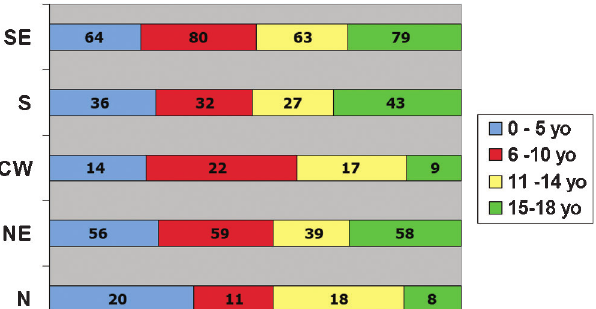
Figure 4 - Comparative distribution of all cases of pediatric lymphomas by age groups in each geographic region. N: North; NE: Northeast; CW: Central-West; S: South; SE: Southeast.